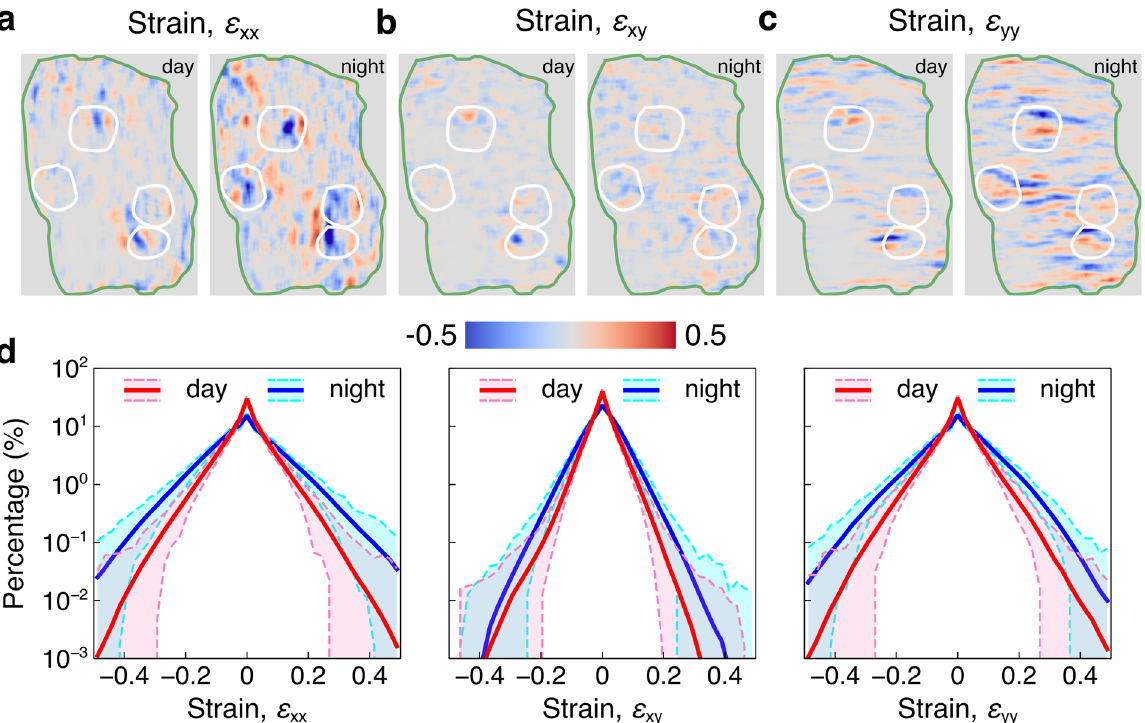
Figure 3. Strains of the coral tissue surface from digital image correlation. (a–c ) Strains ε xx , ε xy and ε yy between the first and the second picture from day and night are shown in the left and right panel, respectively. Green curves in ( a ) and ( b ) represents the edge of the fragment and white curves enclose the polyps. ( d ) The percentage histogram of the strains ε xx , ε xy and ε yy are shown in the left, middle and right panels, respectively. The red and blue curves indicate the means of each strain during day and night. The pink and cyan regions are variations during day and and night. The corresponding variation ranges are shown in pink and cyan. According to the histogram (Fig. 2c), most of the areas of the coral tissue surface are barely moving, i.e., nearly zero displacement. For the moving part, more areas of the coral tissue surface are contributing to the motion at night since the blue curves are above the red curves, coinciding with the displacements shown in Fig. 2a,b. Furthermore, the histogram of displacement